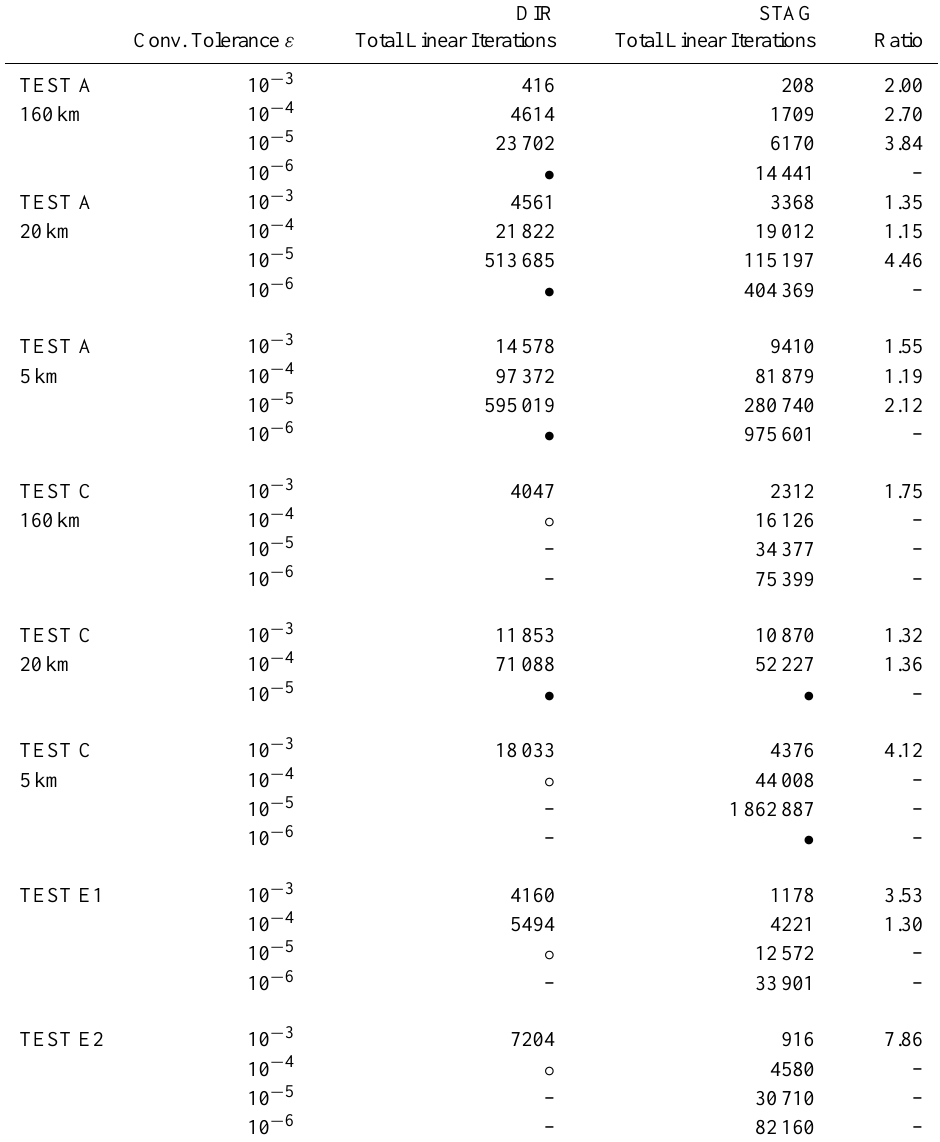
Table 2. Convergence behaviour of the DIR and the STAG discretisation for the ISMIP-HOM experiments. The convergence tolerance is equal for linear and non-linear iterations and varied from 10 − 3 to 10 − 6 . Note that the number of linear iterations is proportional to the computational costs. “ • ” signifies that the accuracy could not be reached and the convergence was manually stopped after an reasonable number of non-linear iterations. Divergence of the resultant velocity field is marked with “ ◦ ”. If a certain tolerance was not reached in either way, the same experiment was not conducted with higher accuracy